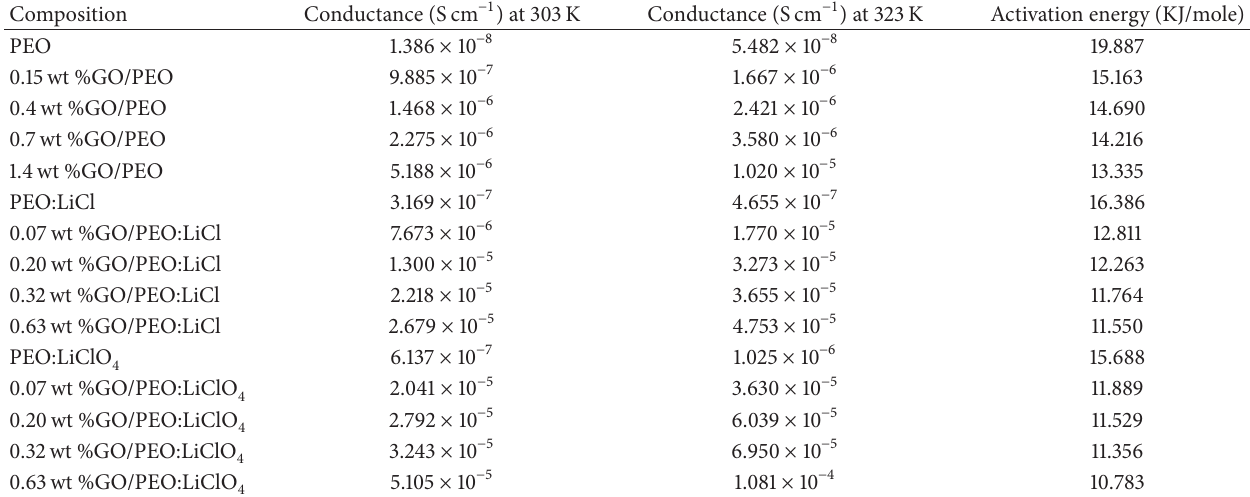
Table 1: Composition, conductance, and activation energy values of the